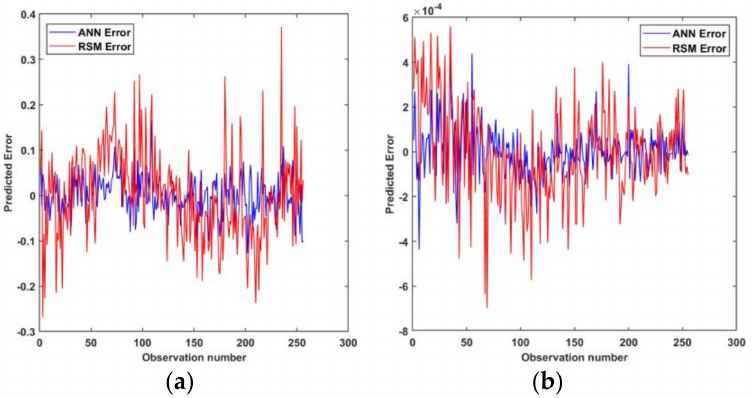
Figure 16. Prediction error for observations: ( a ) centerline deviation, ( b ) fracture